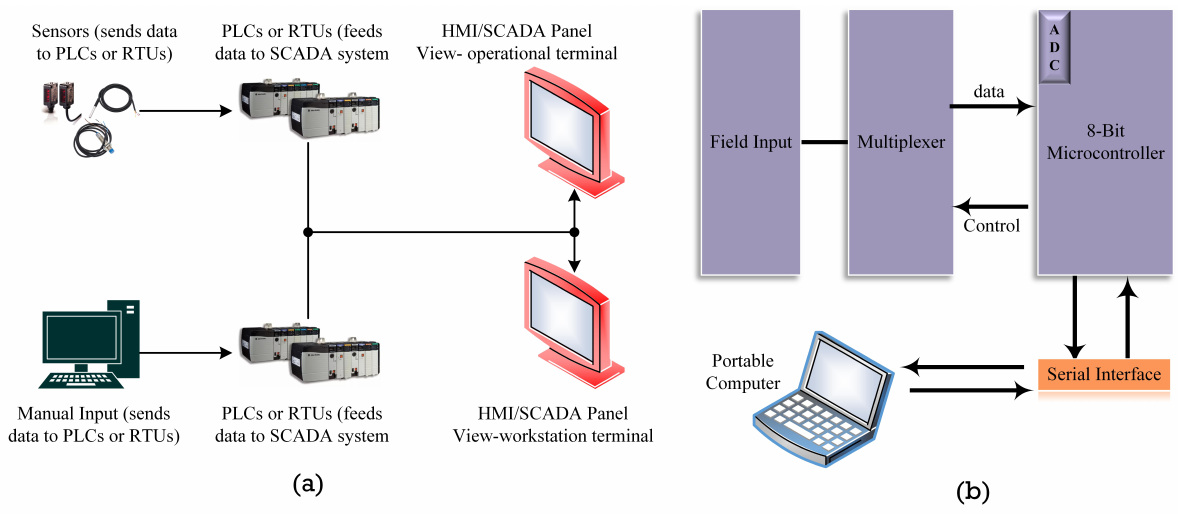
Figure 1. SCADA System. ( a ) Representation of the hardware architecture of a SCADA system, including field devices such as PLCs (programmable logic controller) or RTUs (remote terminal units) and the computer with the controller. ( b ) Example of implementation using a Portable Computer and microcontrollers via a serial